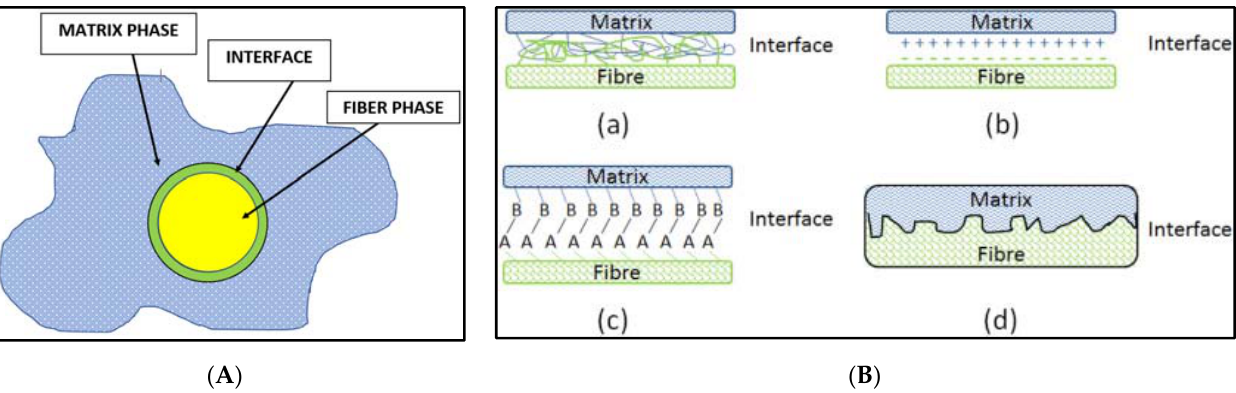
Figure 10. ( A ) Fiber-matrix composite material structure. ( B ) Fiber-matrix interfacial bonding mechanisms: ( a ) molecular entanglement following interdiffusion, ( b ) electrostatic adhesion, ( c ) chemical bonding, and ( d ) mechanical interlocking [39] (reprinted with kind permission from Elsevier).